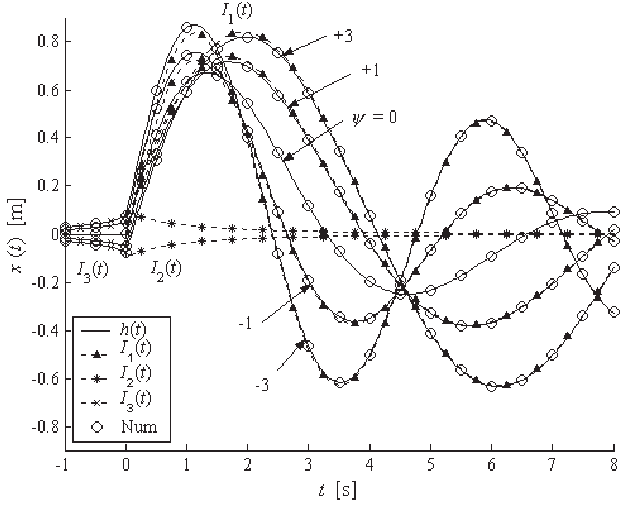
Fig. 7. Impulse response for the complex damped SDOF system in function of ψ for ζ m = 0 . 3